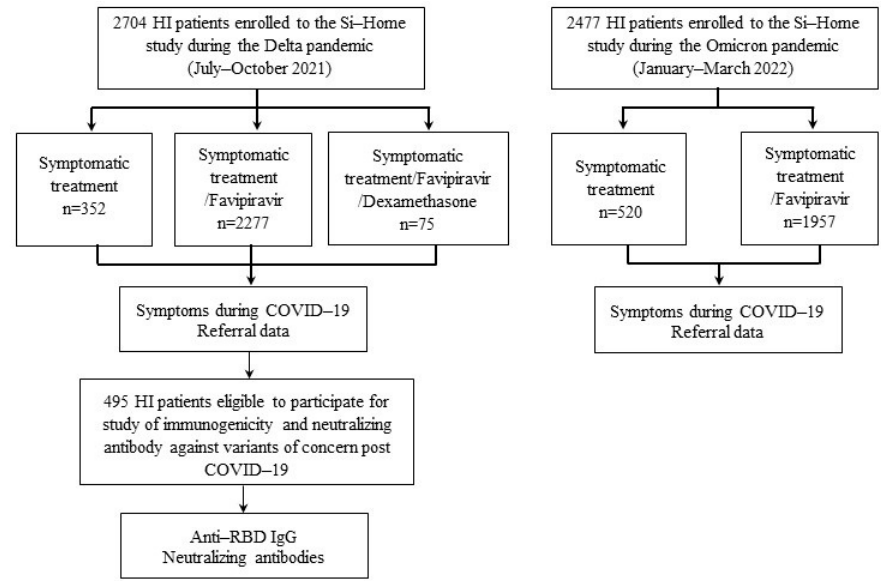
Figure 1. Study source recruitment and